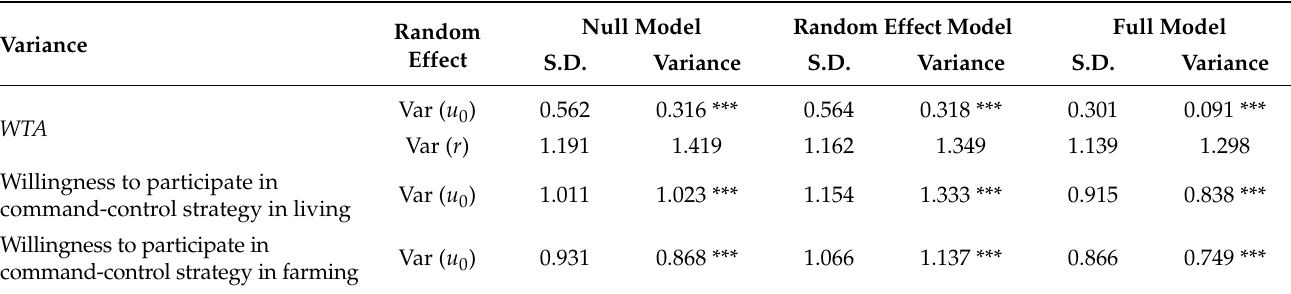
Table 7. Effect comparison of the three types of